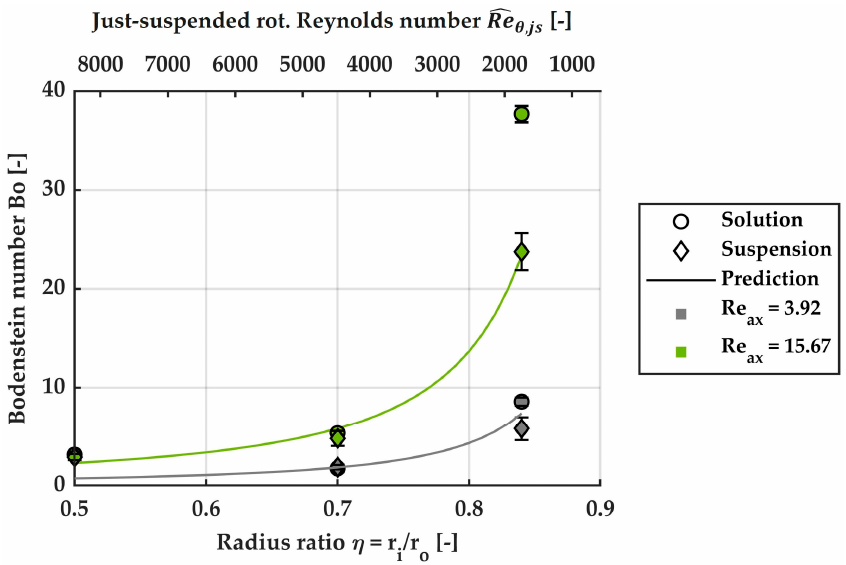
Figure 10. The Bodenstein number Bo of the liquid phase as a function of the radius ratio η for the two axial Reynolds numbers Re ax (distinguishable by color) for particle‑free solution flow as well as for suspension flow ( x 50,3 = 348.82 µ m; w solid , ala = 5.5 wt.%). The solid lines display the prediction calculated according to the procedure described in Figure 9. Table 4. Radius ratios, rotation rates, and respective rotational Reynolds numbers for validating the prediction of the Bodenstein number in the just‑suspended state. The particle size fraction 200–315 µ m was used at a mass fraction of w = 5.5